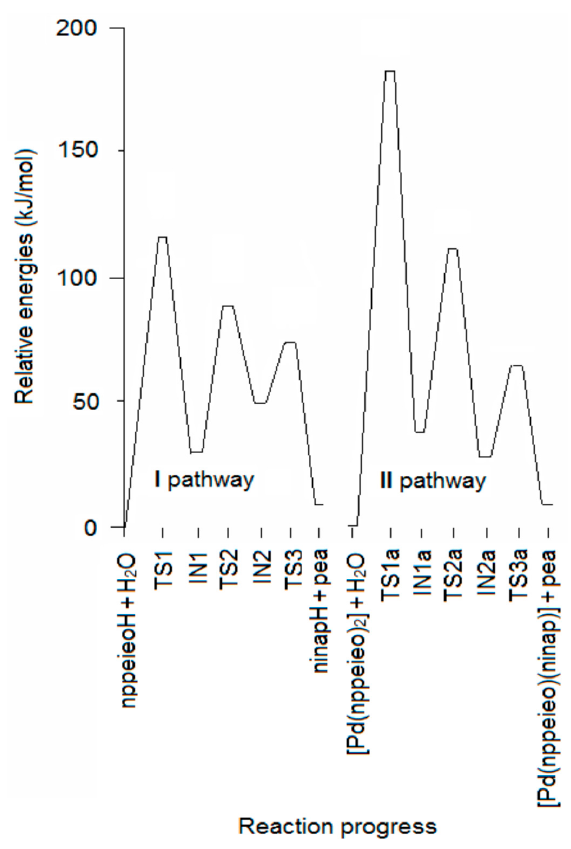
Figure 1. Energy profile for the hydrolysis of nppeieoH.